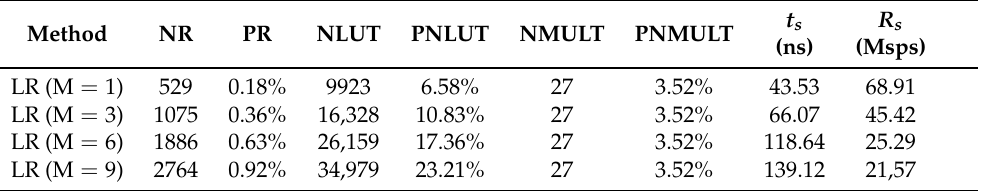
Table 3. Synthesis results regarding the hardware area occupation, processing time, and throughput for the linear regression (LR) prediction technique, NI = 3, and varying M from 1 to 9.